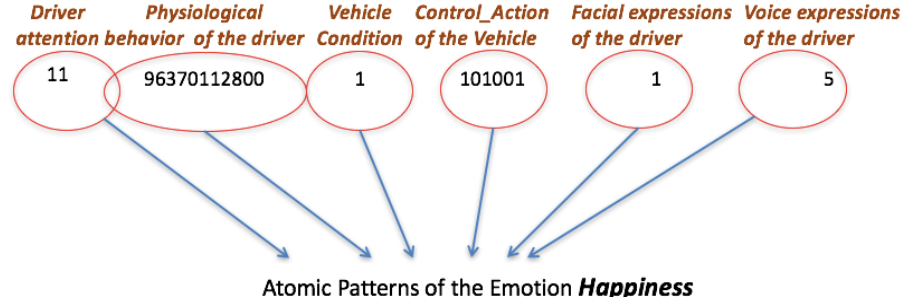
Figure 4. Ar2p model for the Emotion Layer (it recognizes Happiness).